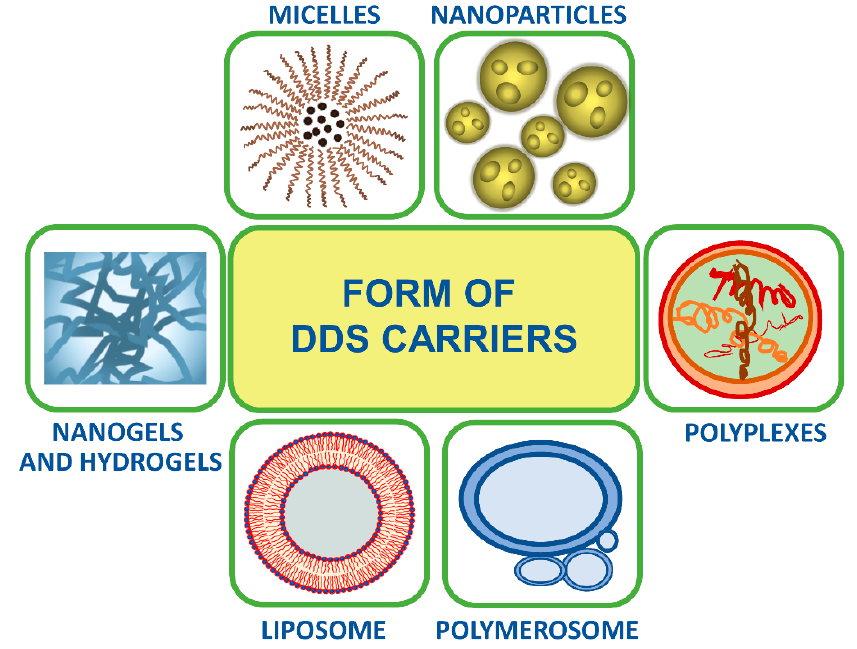
Figure 7. Forms of drug carriers obtained from polymers bearing cholesteryl moiety/ies.